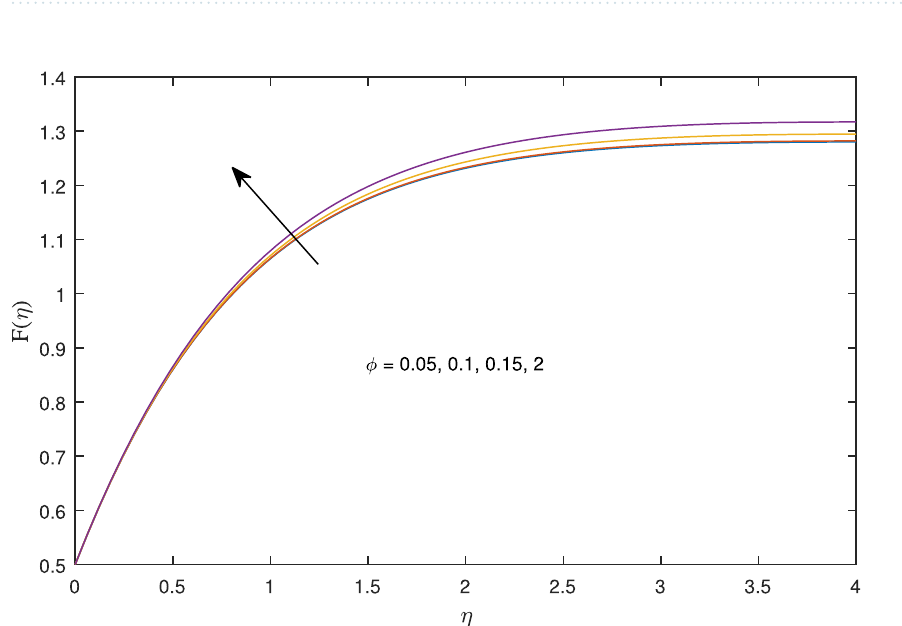
Figure 17. Effects of critical shear rate β on temperature profile, when c 0.1 and Pr φ =